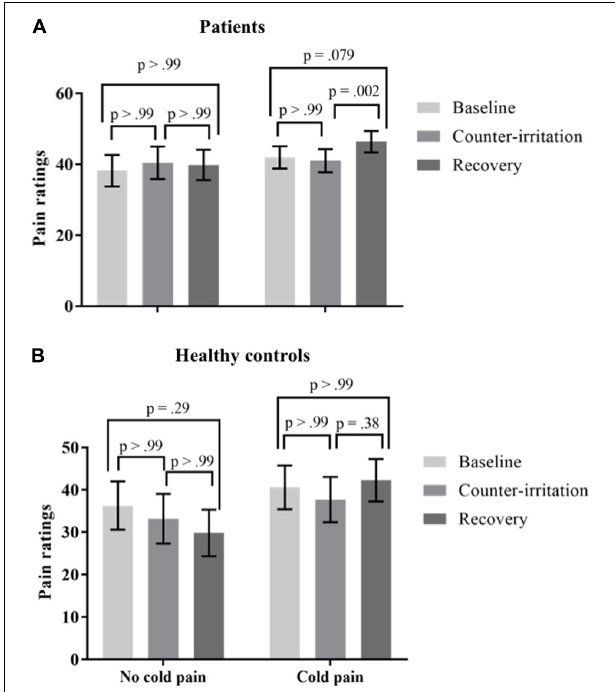
FIGURE 3 | Least square mean pain ratings for electrocutaneous stimuli for (A) patients and (B) Healthy controls (HC) who did and did not experience the counter-irritation stimulus as painful [cold pressor arm wrap (CPAW) pain rating ≥ 20] in the baseline, counter-irritation and recovery phase. 23 patients and 14 HC found the CPAW not painful, 46 patients and 17 HC found the CPAW painful. p -values are corrected for multiple testing with the stepdown Bonferroni method. Vertical bars denote standard